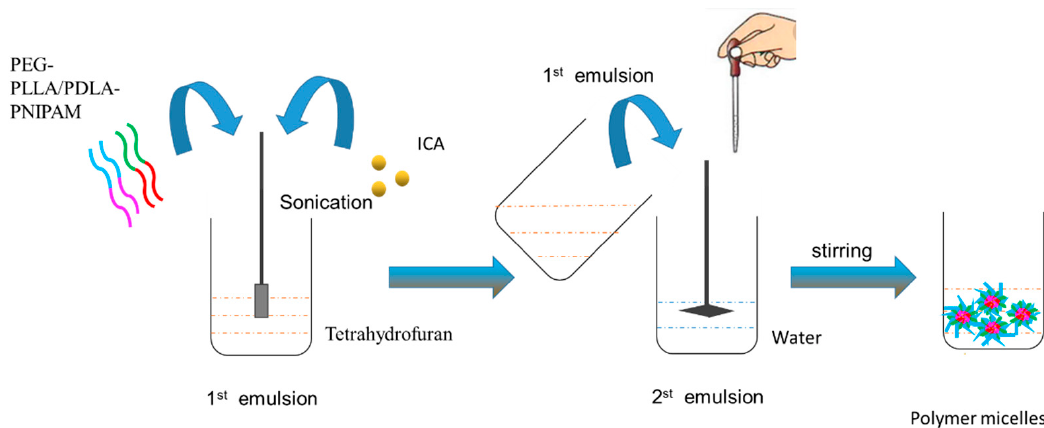
Figure 2. Preparation of drug-loaded micelles.